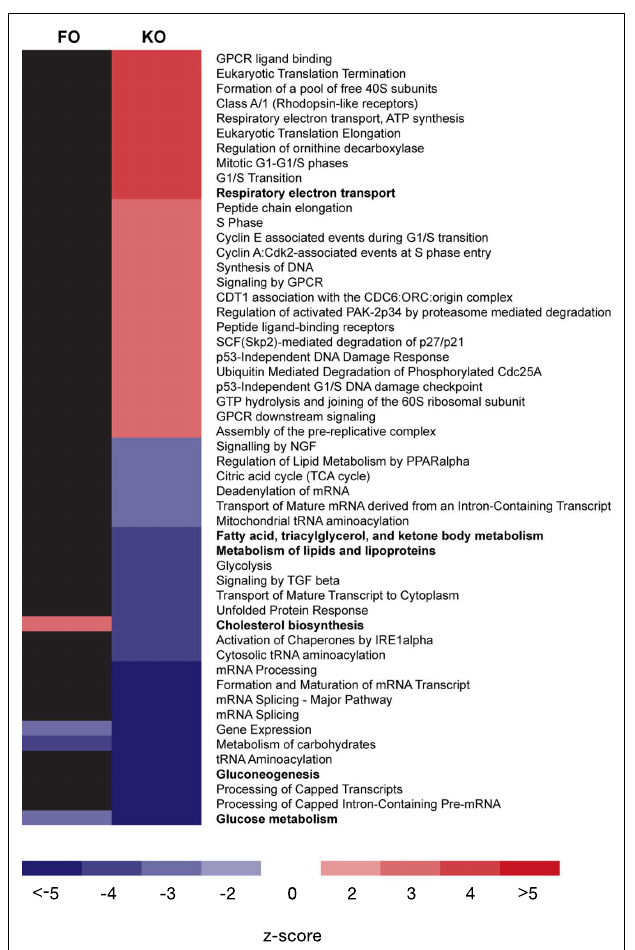
FIGURE 1 | Metabolic pathways regulated by either fish oil (FO) or krill oil (KO) in mouse liver. Pathway analysis (PAGE, see Materials and Methods) was used to identify functional classes of genes from the Reactome database that were differentially regulated in supplemented diets compared to the Control diet at p < 0.001. Red or blue fills represent the magnitude of the z -score and indicate if a pathway was significantly increased or decreased in activity (respectively) by treatment. Each row represents an individual Reactome pathway and each column represents the effect of either FO or KO on that pathway. Only those Reactome IDs represented by at least 10, but not more than 1000, genes are shown. Pathways indicated by bold are discussed in detail in the manuscript.